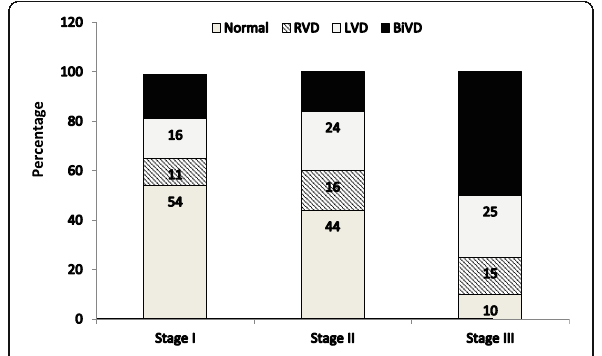
Fig. 3 Frequency of ventricular dysfunction based on stages of